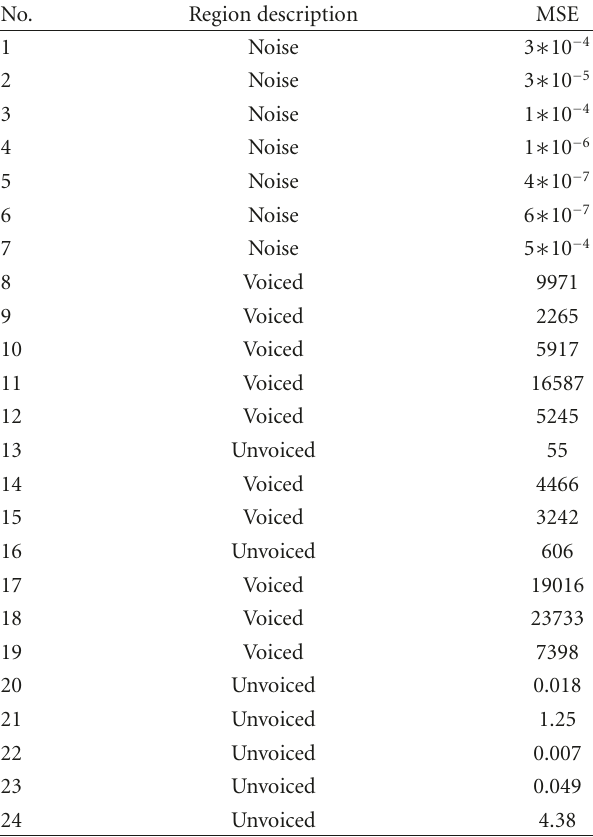
Table 1: MSEs for some of the tested speech